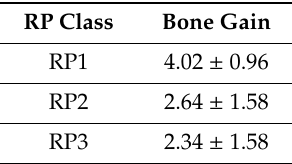
Table 4. Bone gain in relation to RP class.